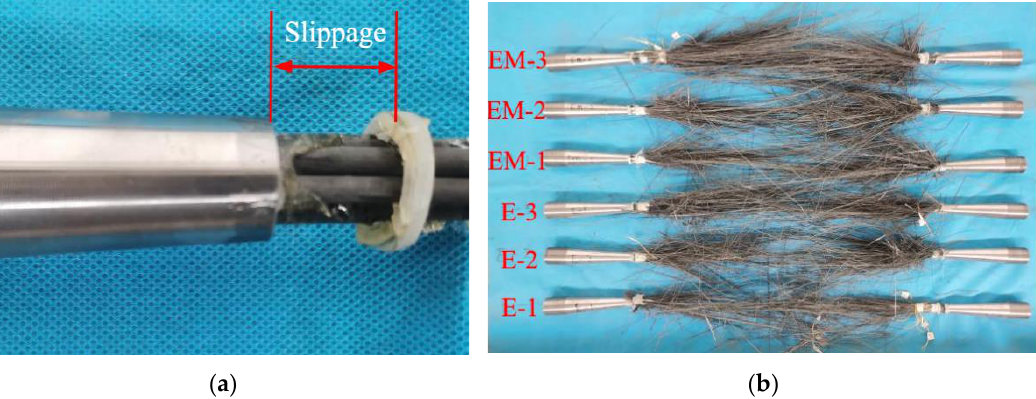
Figure 11. The damage form of CFRP strand. ( a ) CFRP strand pull-out failure; ( b ) explosive destruction of CFRP strand.